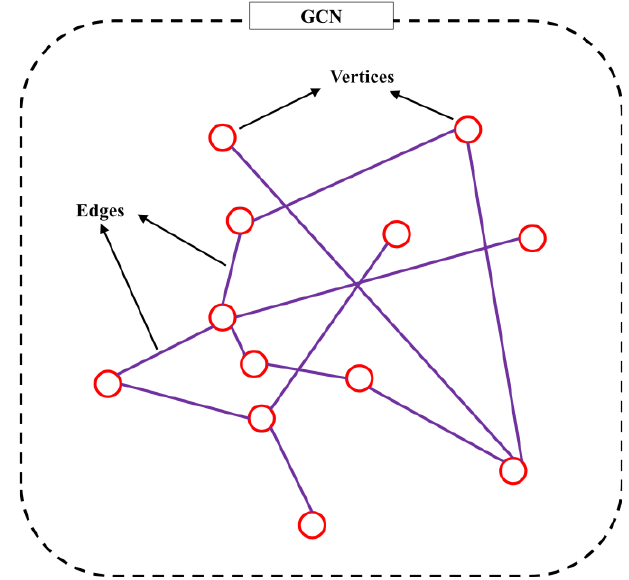
Figure 2. General structure of a graph.